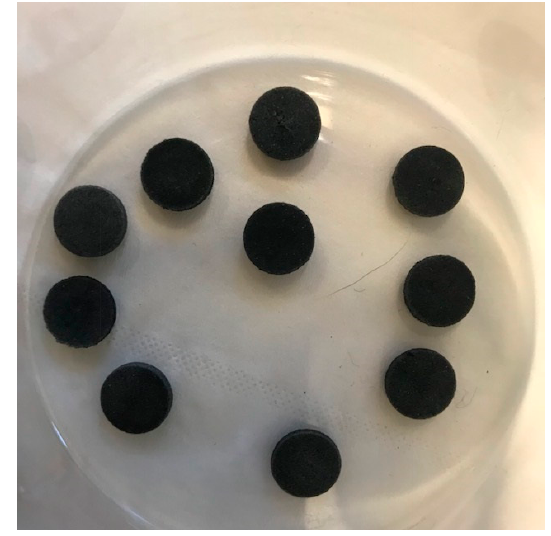
Figure 1. Photograph of prepared graphene tablets (GO-Tabs).